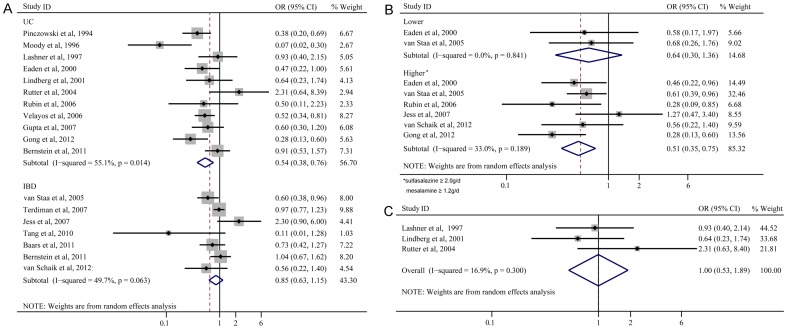
Forest plots of subanalyses of UC and IBD (A), average daily dose of 5-ASA use (B), and extensive UC (C).